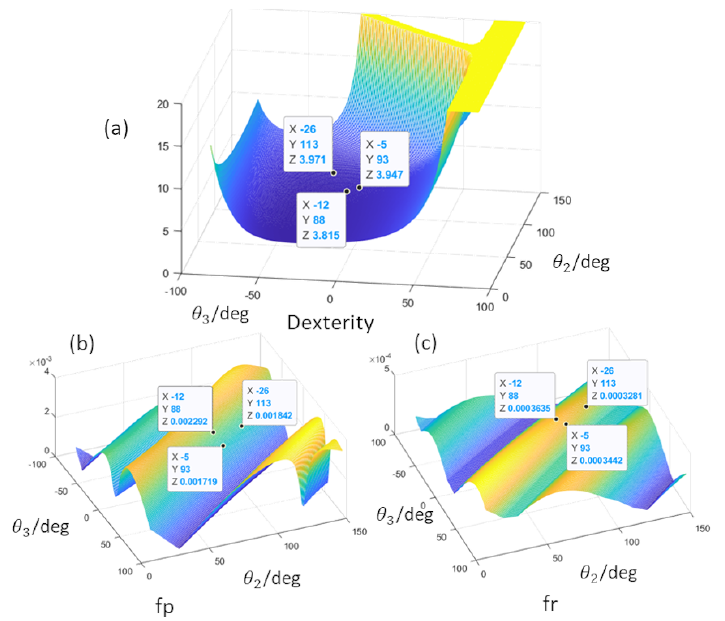
Figure 16. The platform of the stiffness identification; the calculation results of ( a ) dexterity, ( b ) f p and ( c ) f r under θ 2 and θ 3 .